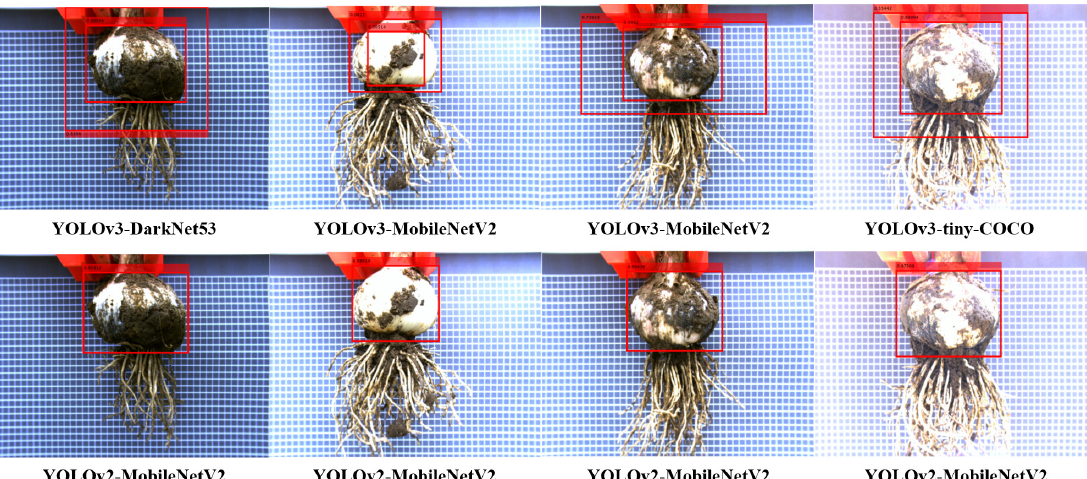
Figure 11. Test results of YOLOv2-MobileNetV2.